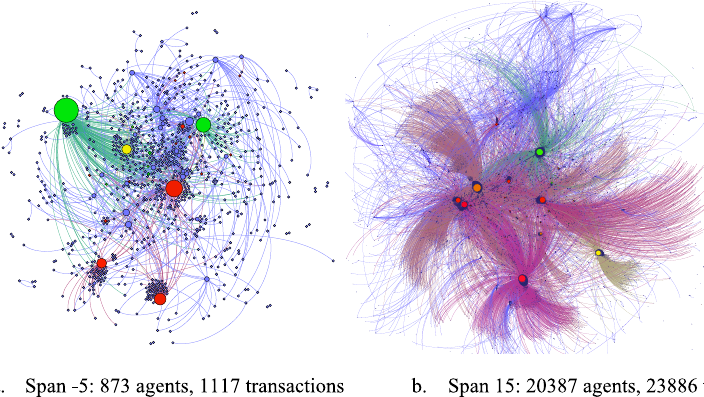
Fig. 2 Example transaction network. a The visualization of the transactions simple-graph pre-incentives period (span -5). The network includes 873 agents and 1117 transactions. b The visualization of the transaction simple-graph in the incentives period (span 15). The network includes 20,387 agents and 23,886 transactions. Node size represents degree, and color represents agent type: blue for users, green for companies, red for macro-agents, and black for the central bank. The degree of macro-agents and companies is much greater than users. Many users are directly related to macro-agents or companies.